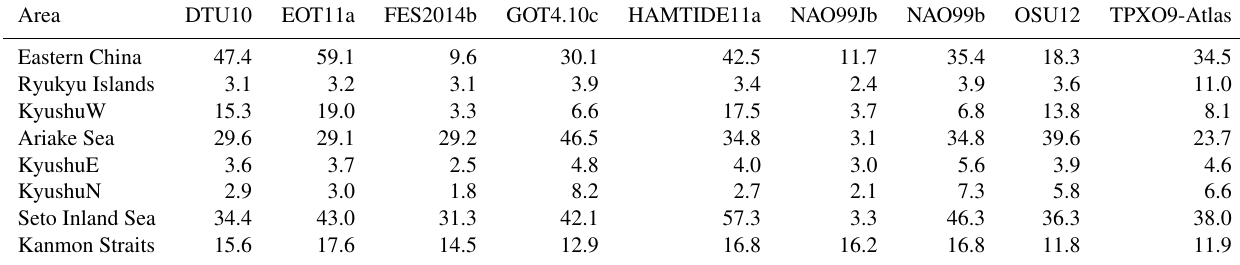
Table 2. The root mean square (in centimetres) of the M 2 phasor differences between each of the nine ocean tide models and the tide gauge observations in each defined subarea of the East China Sea